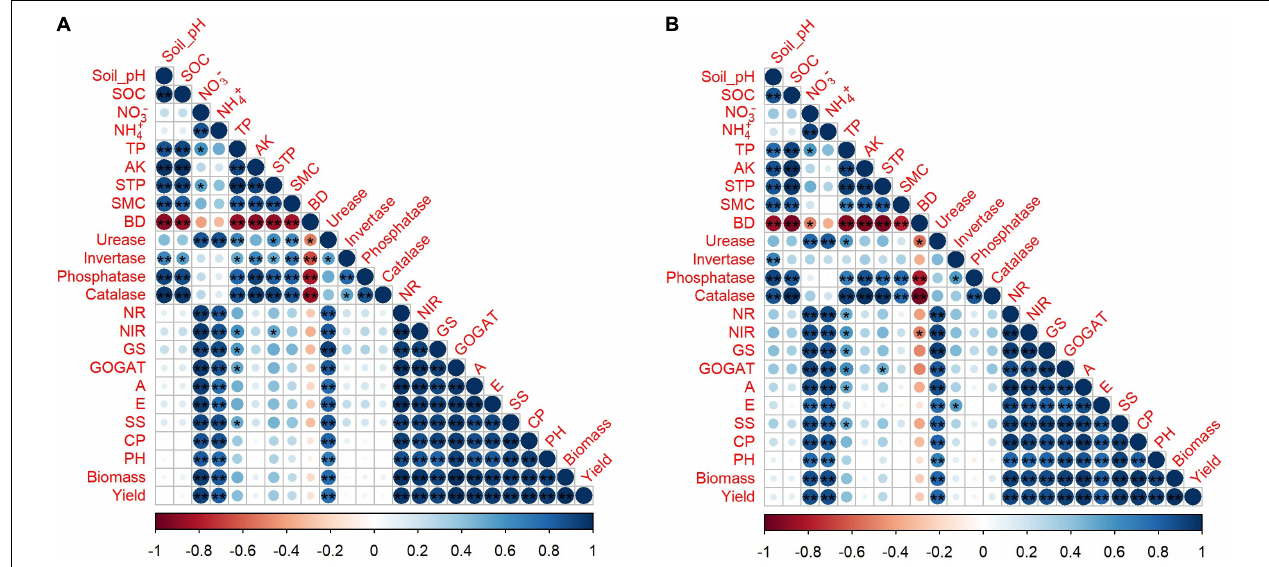
FIGURE 6 | Correlation coefficients between soil physiochemical properties, growth and yield traits in 2019–2020 (A) and 2020–2021 (B) and asterisks represent a significant difference at ∗ p < 0.05, ∗∗ p < 0.01. SOC: soil organic carbon, TP: total phosphorus, AK: available potassium, STP: soil total porosity, SMC: soil moisture content, BD: bulk density, NR: nitrate reductase, NIR: nitrite reductase, GS: glutamate synthase, GOGAT: glutamine synthetase, A: photosynthesis, E: transpiration, SS: soluble sugar, CP: crude protein, PH: plant